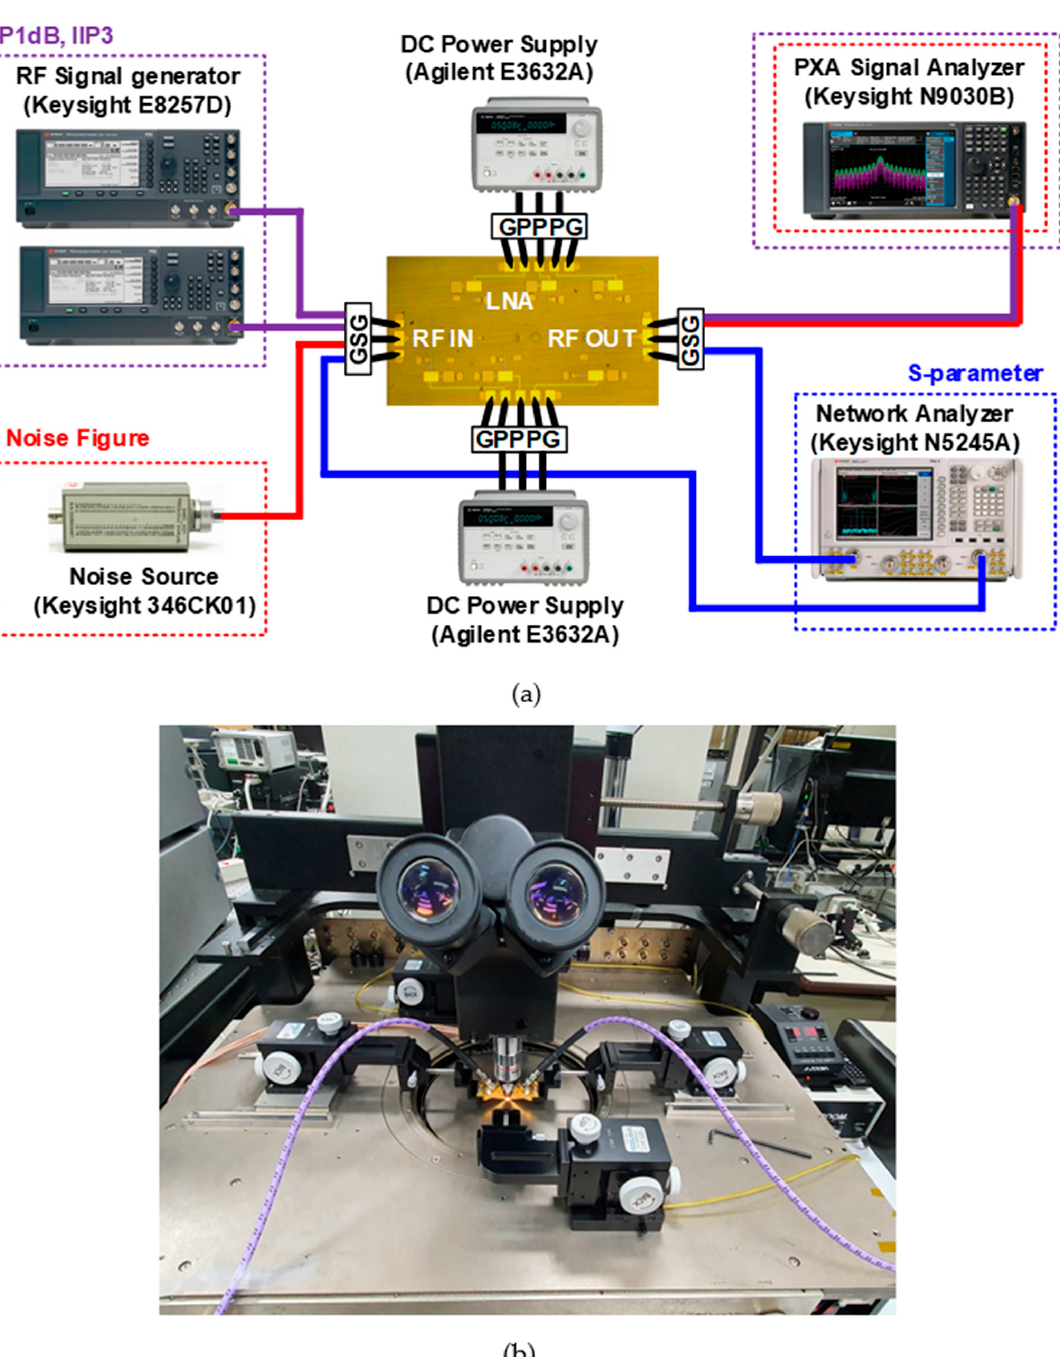
Figure 8. Die microphotograph of the implemented GaN HEMT ‐ based low ‐ noise amplifier.